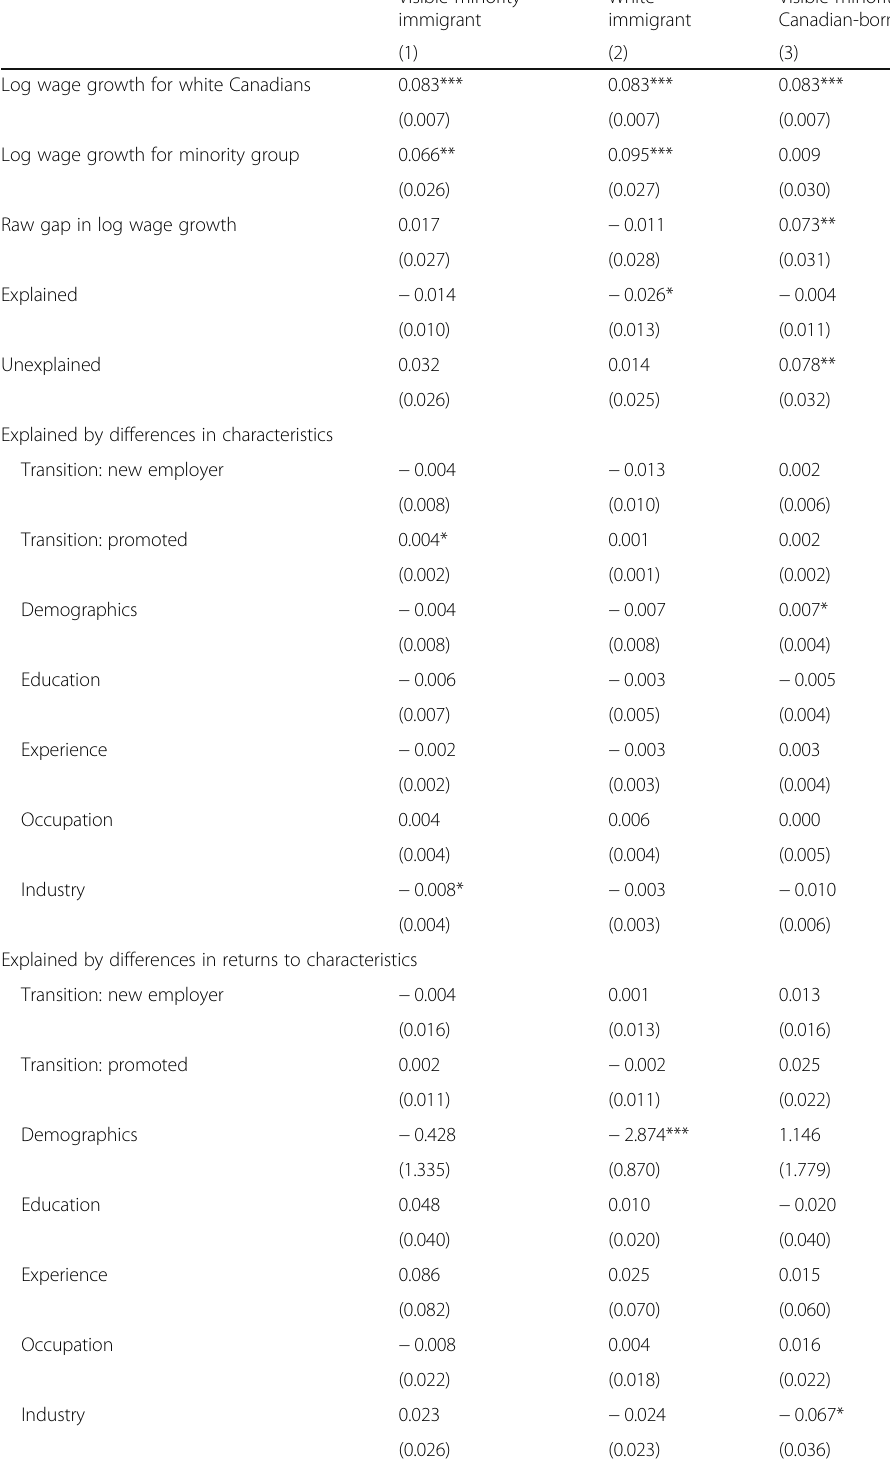
Visible minority White Visible minority immigrant immigrant Canadian-born (1) (2) (3) (0.007) (0.007) (0.007)